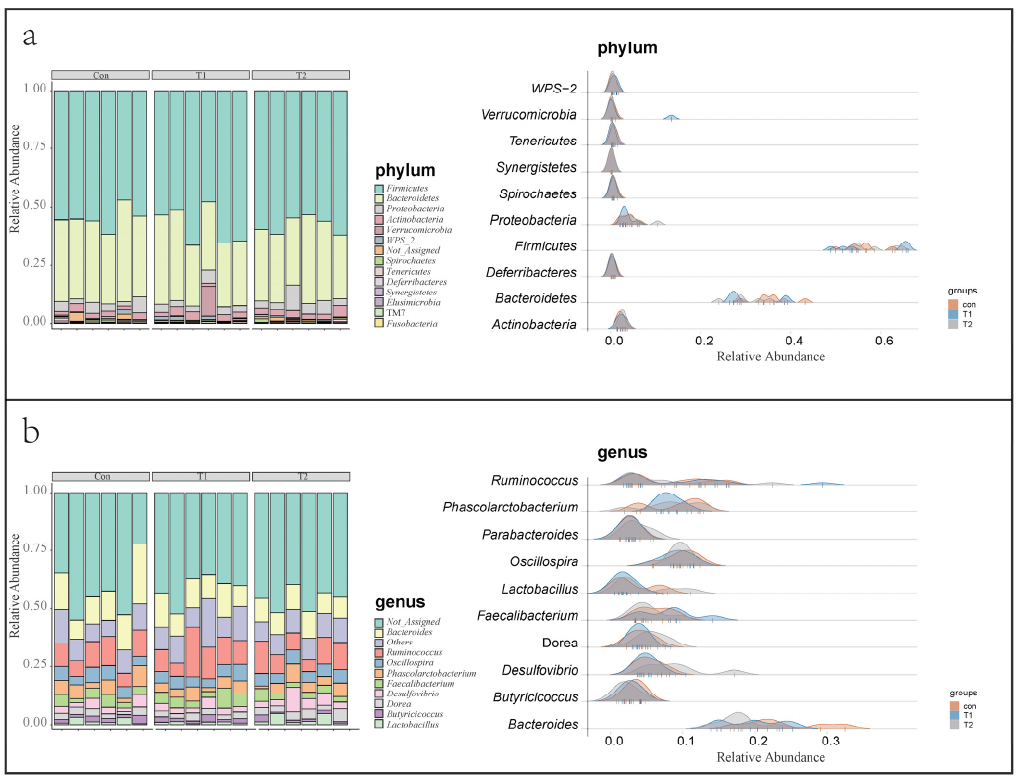
Figure 2. The microbial community structure of cecum. ( a ) Left: stacked bar chart of microbial composition at the phylum level; Right: ridges chart of the microbiota at the phylum level. ( b ) Left: stacked bar chart of microbial composition at the genus level; Right: ridges chart of the microbiota at the genus level.